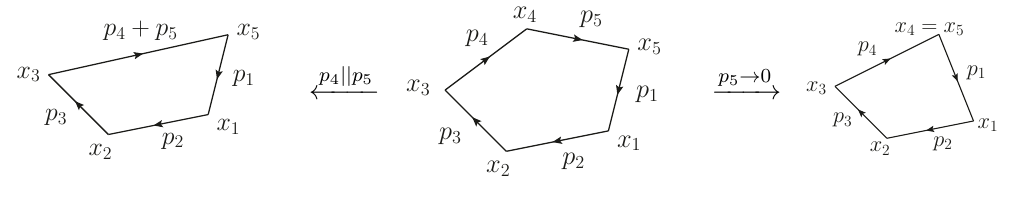
Figure 3 . Soft p 5 → 0 and collinear p 4 || p 5 limit of the five-cusp Wilson loop